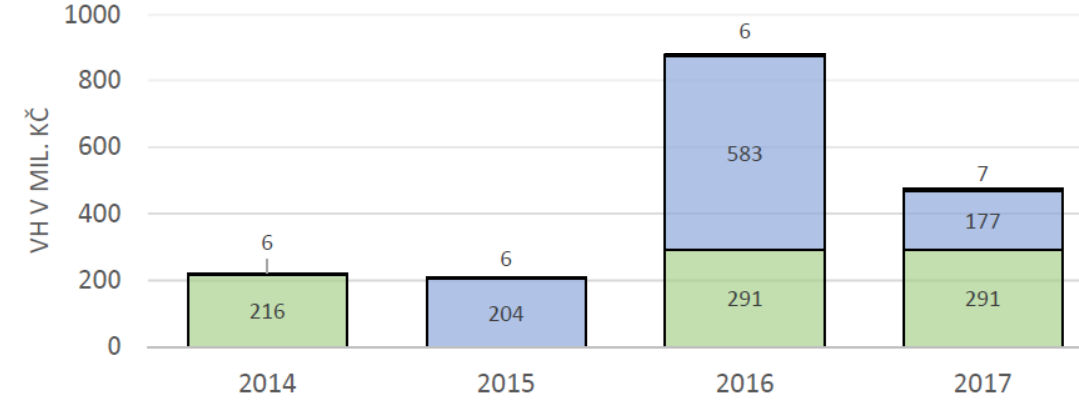
Figure 12: Outflow of profit share and increment retained earnings account of EUROVIA CS (CZK million), (source: Annual report of EUROVIA CS 2014-2018, data processed by the authors) Careful drawing of dividends and the growth of the retained earnings account testify to the responsible behavior of EUROVIA CS (see Figure 13) and may also be related to the fact that the company has been operating on the Czech market for a relatively short time compared to its competitors.